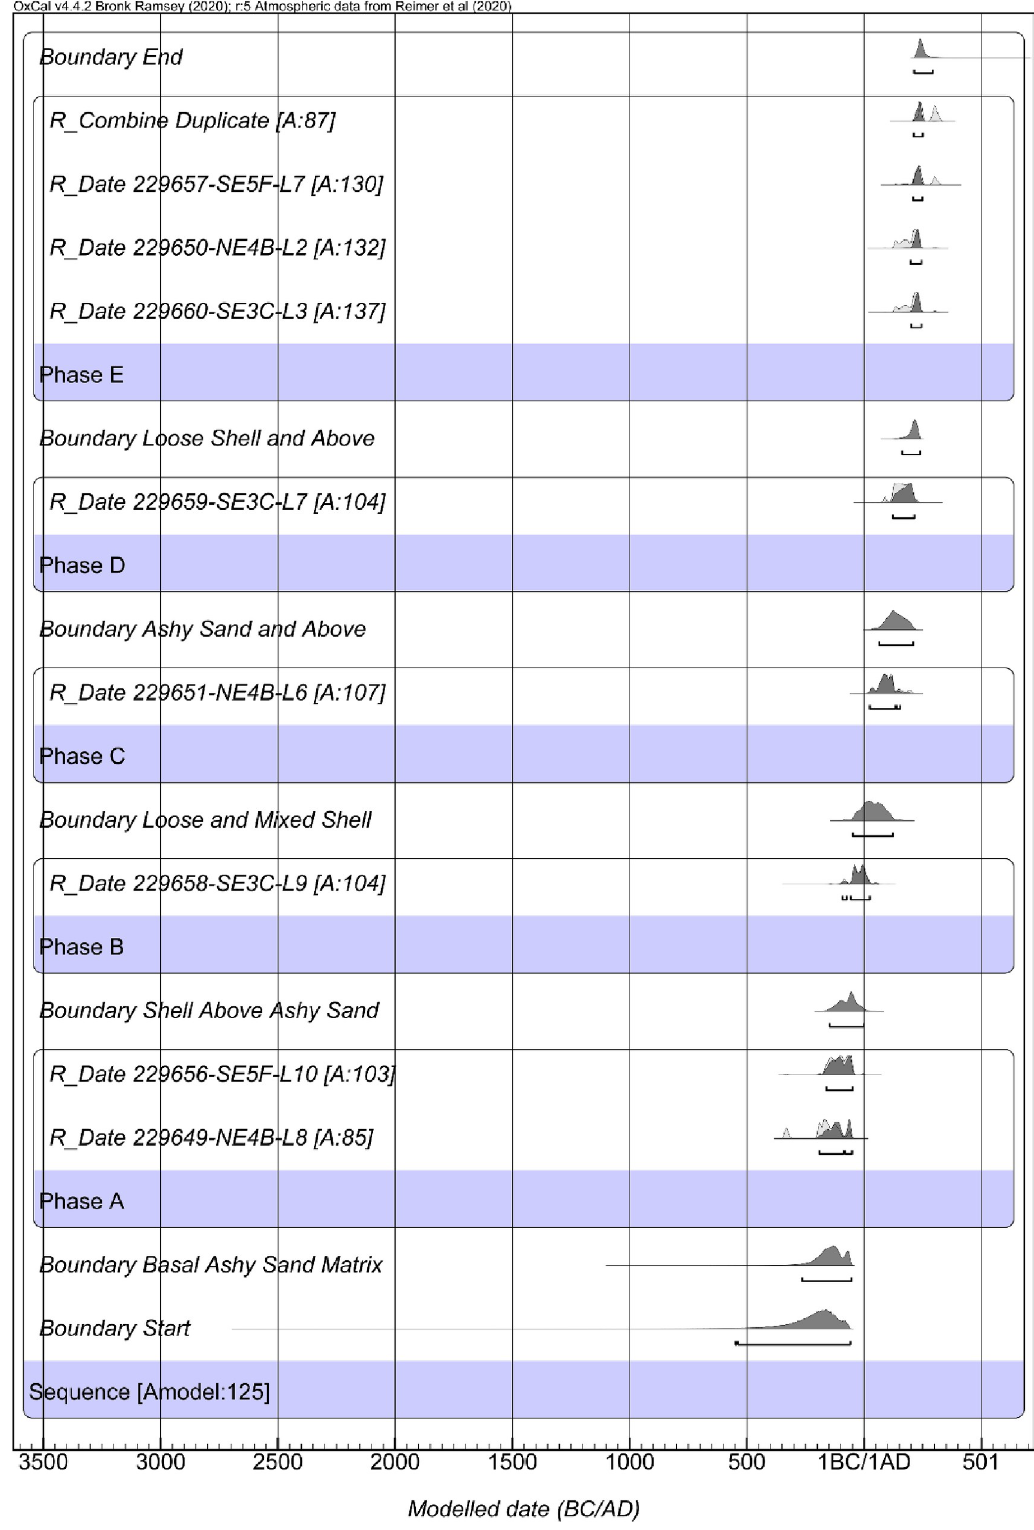
Fig 9. Results of the third iteration of the Palmrose chronological modeling.